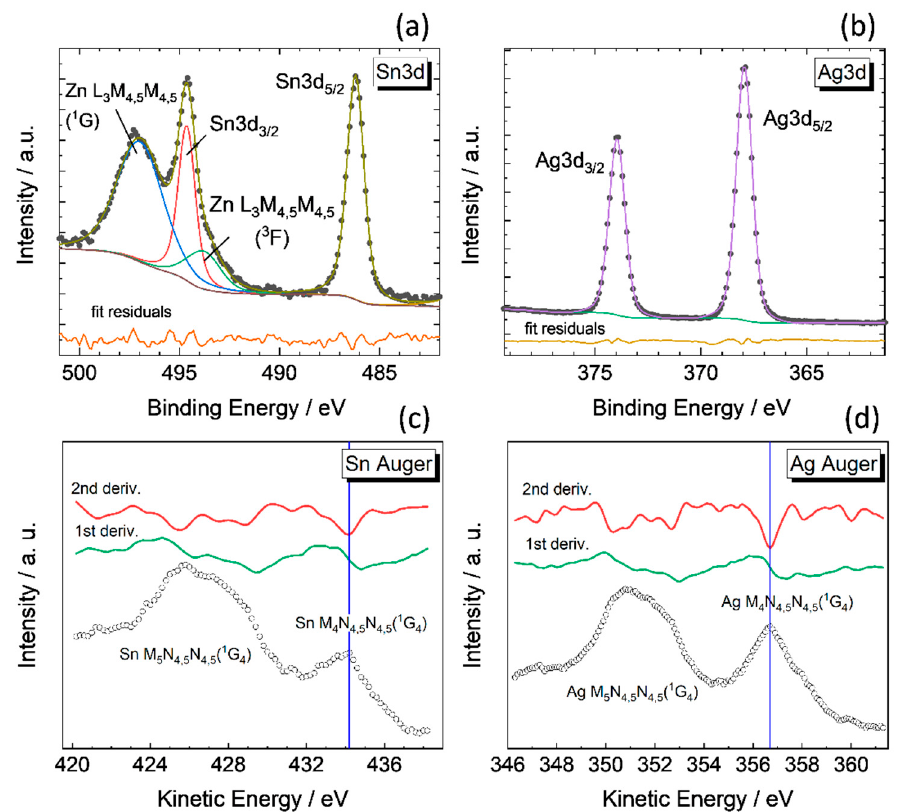
Figure 12. The high-resolution Sn3d ( a ), Ag3d ( b ) core level XPS, as well as the Sn MNN ( c ) and Ag MNN ( d ) Auger spectra of AZTS NCs. The rest of the high-resolution photoemission spectra (S2p, Zn2p, C1s, and O1s) can be found in the supplementary information. The photoelectrons were emitted using a monochromated Al K α excitation, h ν = 1486.7 eV. The sample with the nominal composition Ag 30 Zn 15 Sn 15 S 40 (XPS determined Ag 30 Zn 22 Sn 3 S 45 ) was deposited in the form of a thin film on an ITO